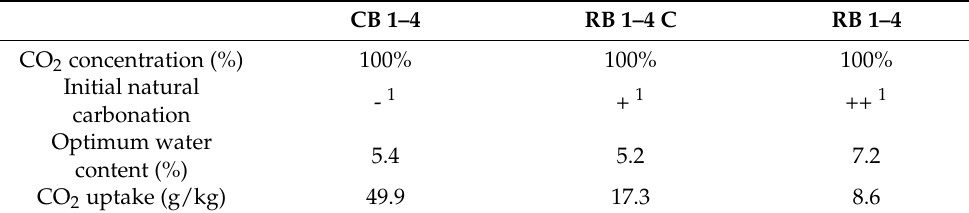
Table 4. Effect of initial natural carbonation of an RCA on CO 2